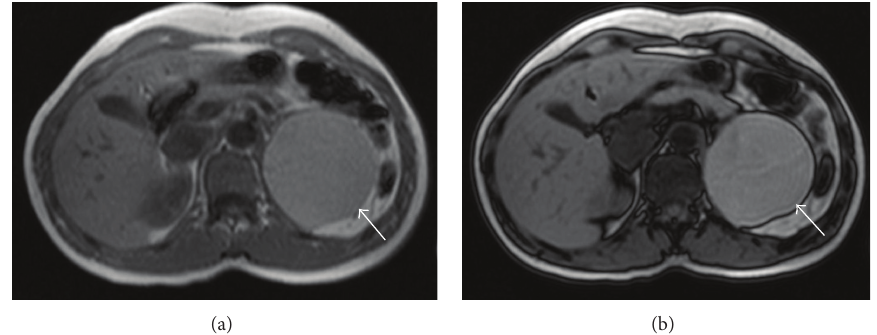
Figure 1: In-phase T1-weighted (a) and opposed-phase T1-WI (b) transverse images demonstrate a well-defined lesion in the left upper retroperitoneum (arrows), with high signal intensity. The lesion preserved high signal intensity on opposed-phase images, suggesting absence of microscopic fat.